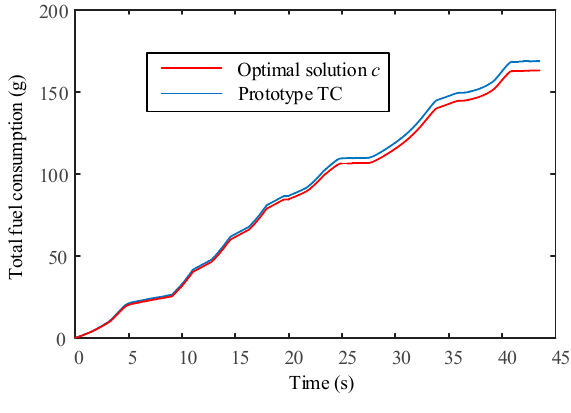
Figure 18. Total fuel consumption.